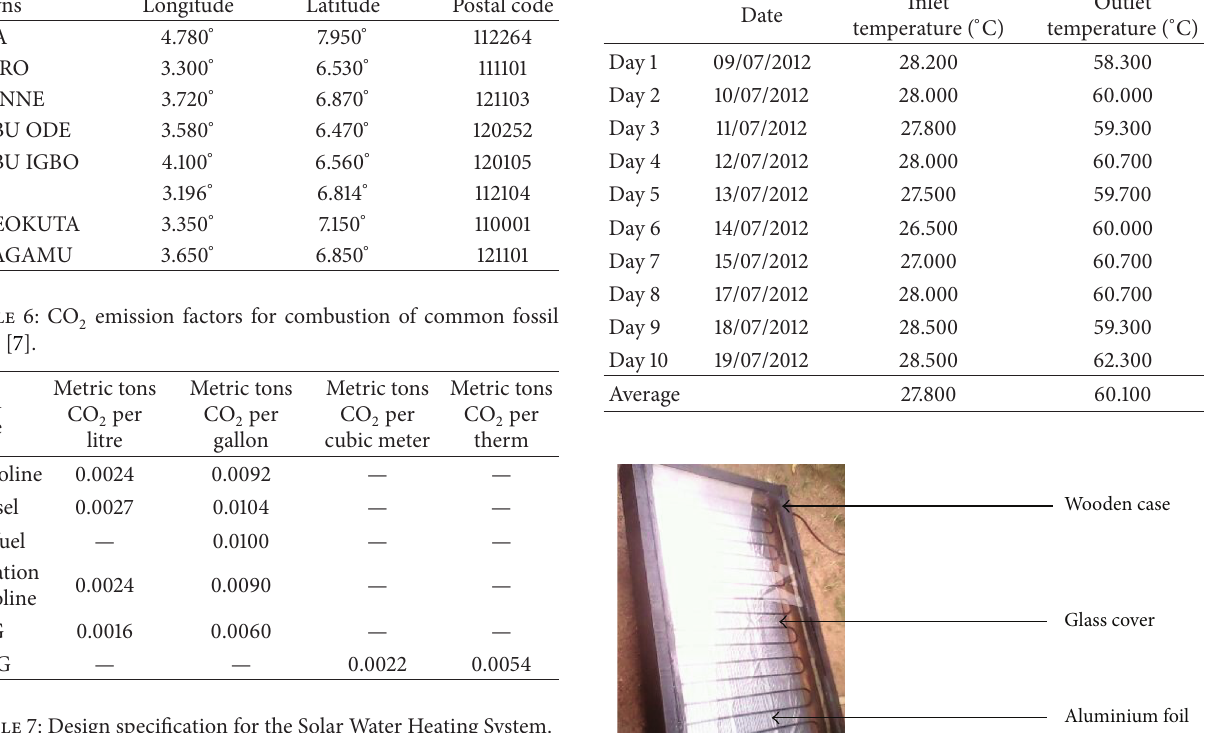
Table 7: Design specification for the Solar Water Heating System. Component